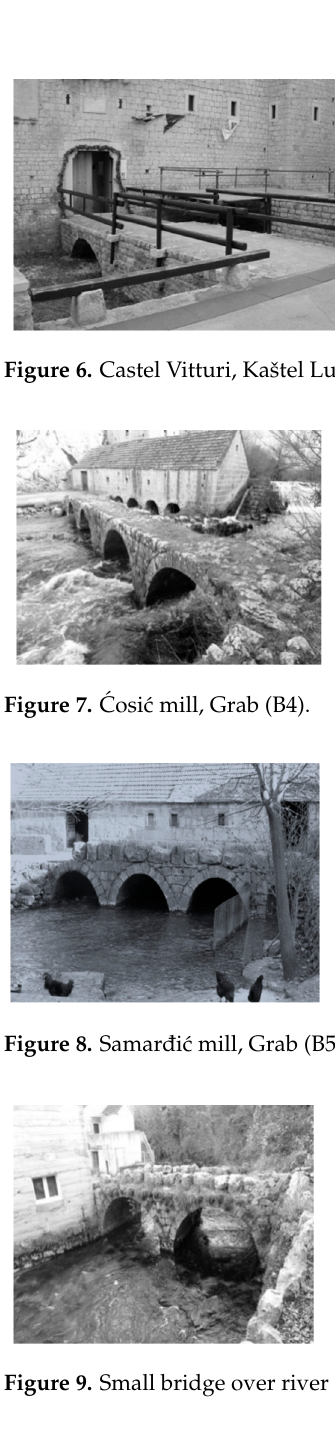
Figure 9. Small bridge over river Grab, Grab (B6).